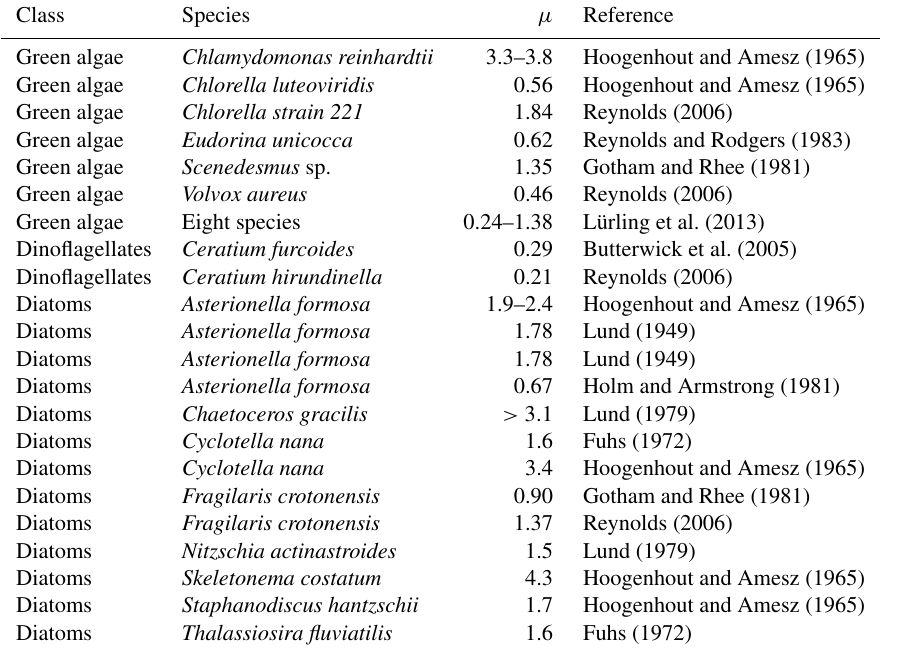
Table 6. Maximal growth rates ( µ ) of different phytoplankton groups.